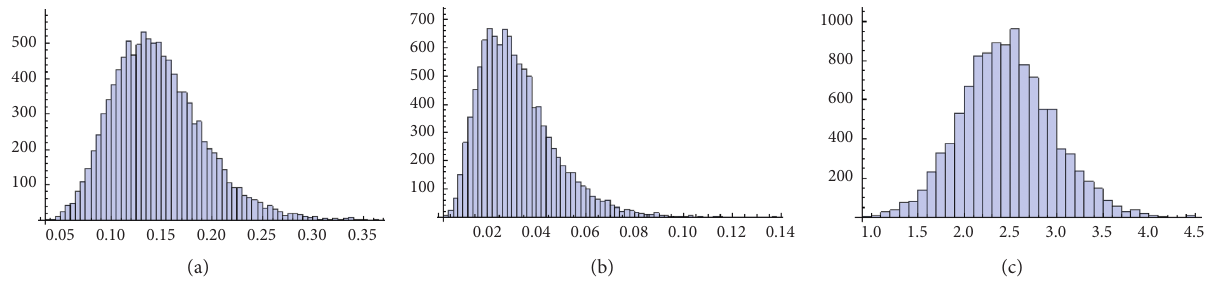
Figure 7: Histogram generated by the MCMC method for α